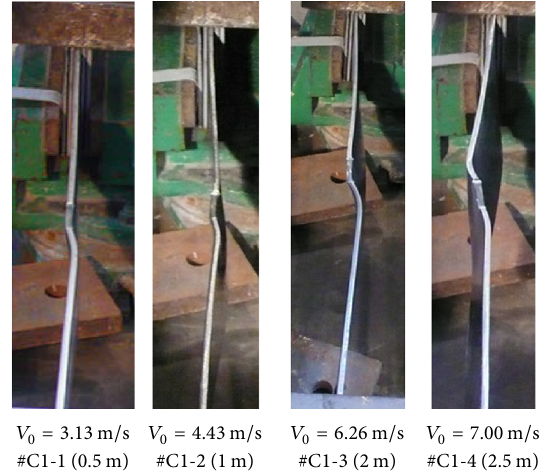
Figure 14: Deformation modes of #C3 (𝛼 = 20, 𝛽 = 20)